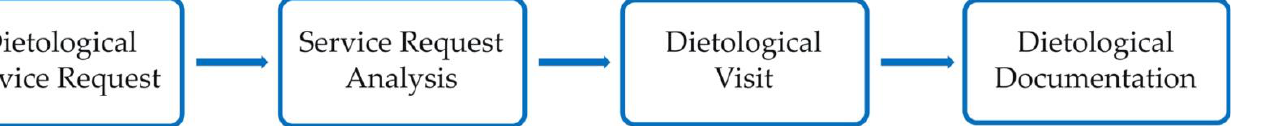
Figure 2. Sub-processes of the current system “dietological council” (adapted from Krotten- müller